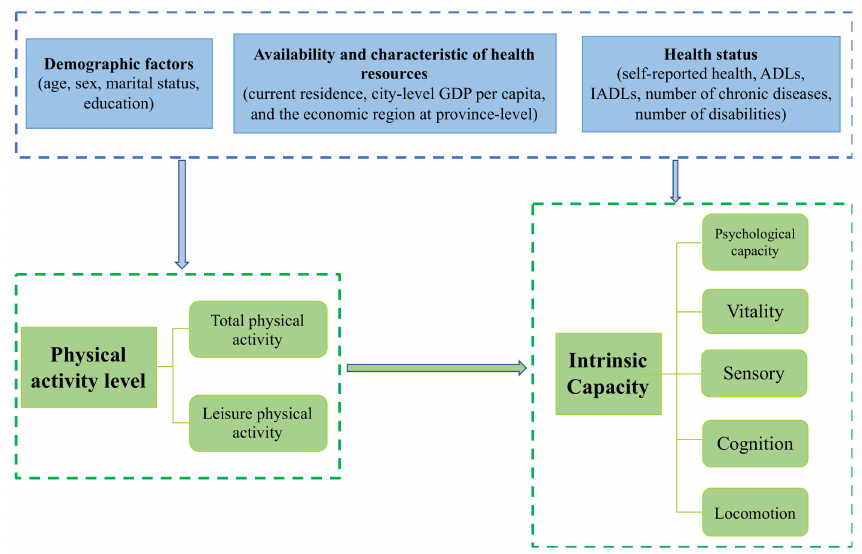
Figure 2. Diagram of association between PA and IC, including potential